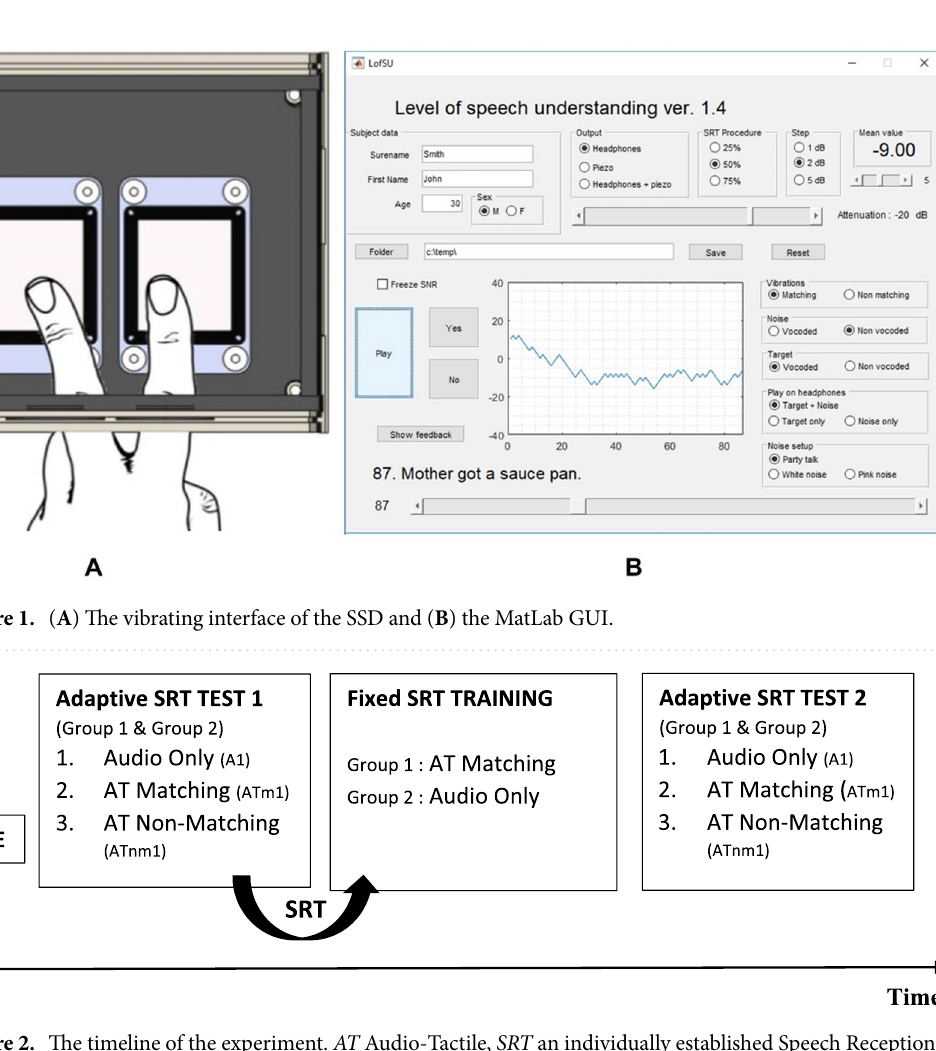
Figure 2. The timeline of the experiment. AT Audio-Tactile, SRT an individually established Speech Reception Threshold that is then used throughout the Training